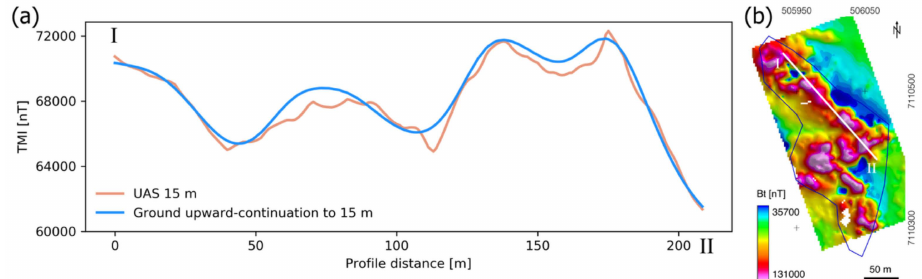
Figure 12. ( a ) The total magnetic intensity extracted from the ground magnetic survey and multi-copter survey made at a flight height of 15 m AGL along a profile (see I and II in ( b )) across the outcrop area. To better compare the datasets, the ground data has been upward-continued to 15 m. ( b ) The location of the extraction profile shown as a white line on the TMI map of the ground survey.